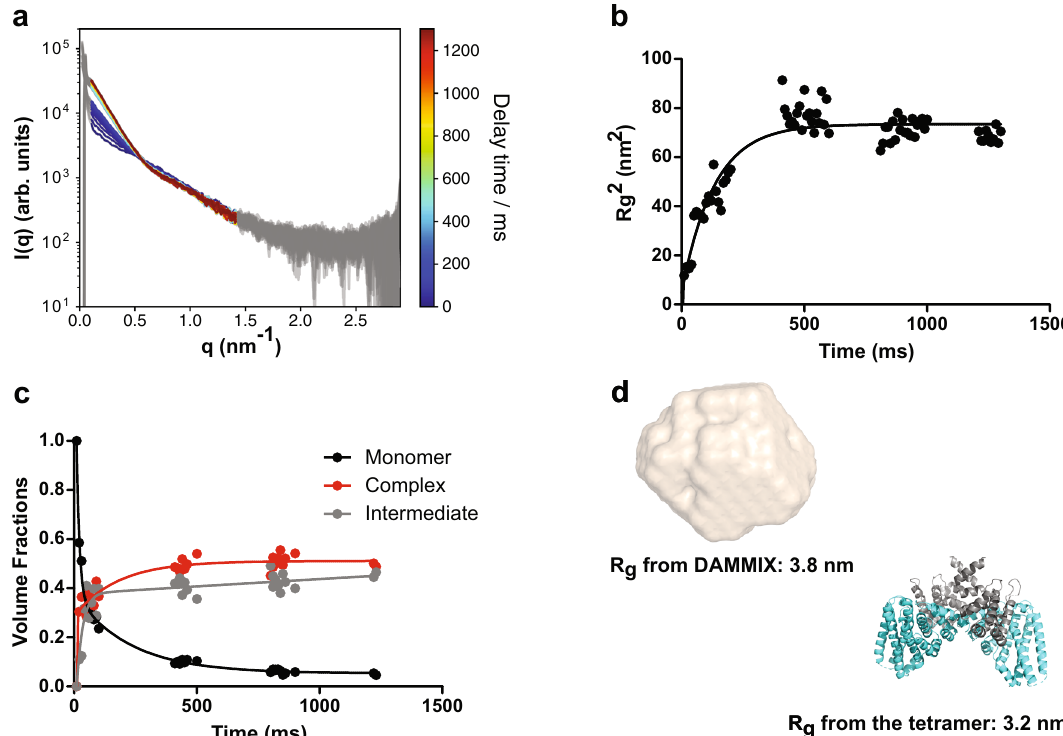
Fig. 8 Time-resolved SAXS data demonstrate a fast assembly of ANTH and ENTH domains in solution. a Buffer-corrected SAXS curves for the time- resolved measurements of the complex formation between ANTH and ENTH in presence of 200 μ M PIP 2 . For a better visibility, the data were smoothed with a Savitzky-Golay fi lter (51-point window, 2 nd order polynomial). Delay times are color-coded from 0 ms in blue to 1200 ms in dark red. The shape of the curve changes dramatically from the initial time points after 400 ms when the curve stabilizes. b Evolution of the R g 2 data of the time-resolved SAXS data set over time. After 500 ms the R g is relatively constant in all curves. A single exponential fi tting was performed and the half-time obtained was ~91 ms. c Volume fractions of DAMMIX obtained using the SAXS curves. The contribution of the unknown component is labeled as “ Intermediate ” . The volume fractions were fi tted to a bi-exponential function to obtain the time constants (fast constant ~8 ms, slow constant around ~150 ms). d DAMMIX ab initio model obtained for the intermediate component vs AENTH tetramer structure from the 16-mer cryoEM map solved. The dimensions of the tetramer and the DAMMIX ab initio model are rather similar, which could indicate that the unknown component of the SAXS data could be tetramers forming in a solution that later on assemble further into larger oligomeric